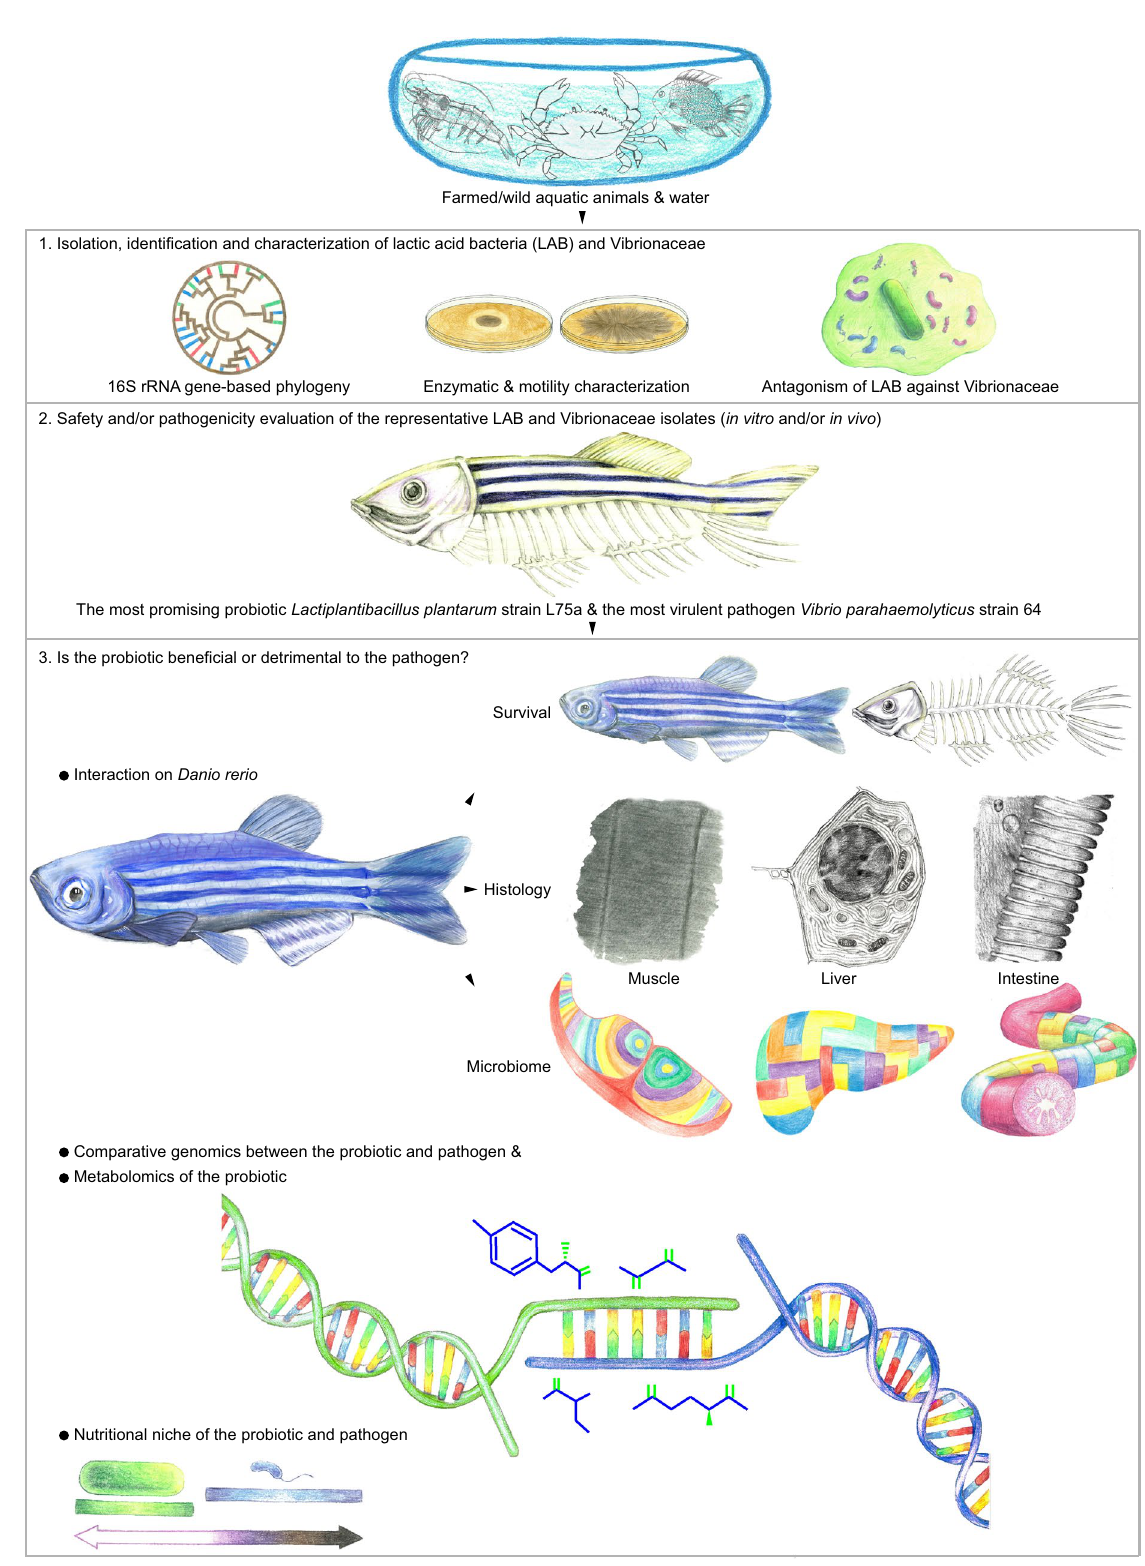
Figure 1. Overall strategy to decipher the beneficial or detrimental impacts of the probiotic against pathogen on zebrafish D. rerio , an aquatic animal